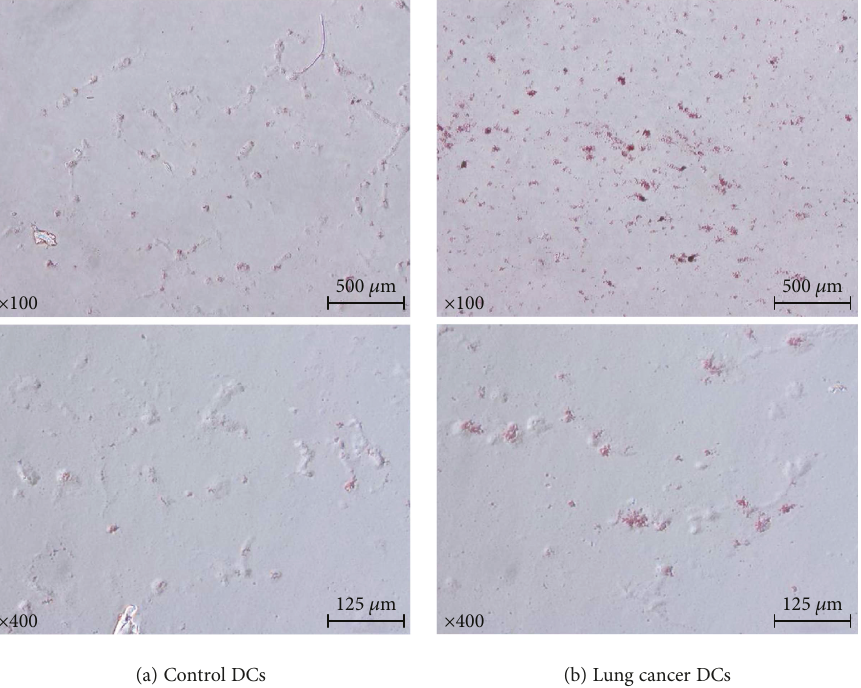
Figure 7: Oil Red O staining. Oil Red O staining is (a) low in the controls and (b) high in the stage IV lung cancer patients (representative cases).